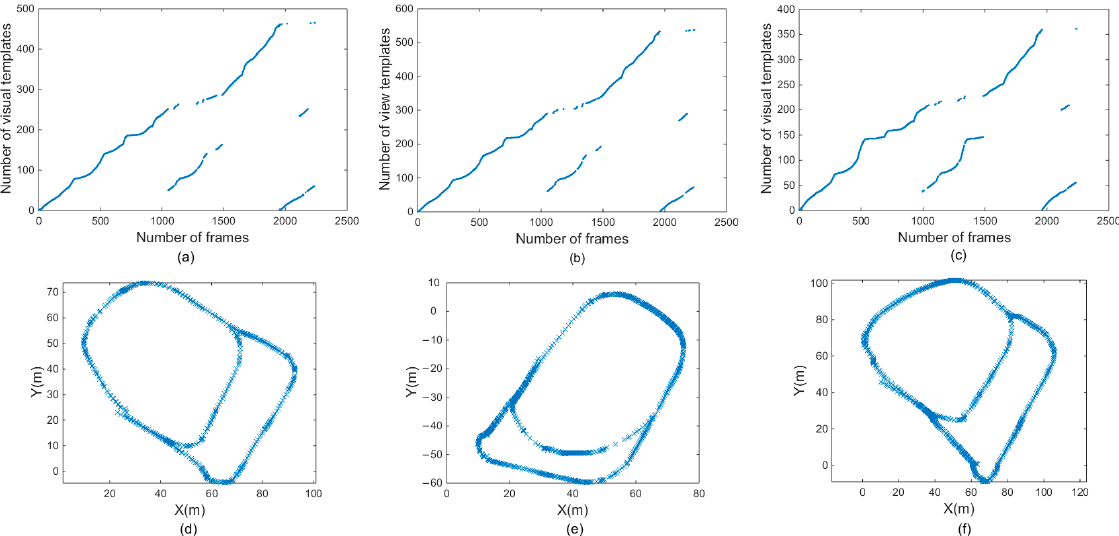
Figure 10. Experimental results of the second scene. ( a , d ) are visual templates and experience map output by traditional RatSLAM. ( b , e ) are visual templates and experience map output by RatSLAM based on FT model. ( c , f ) are visual templates and experience map output by RatSLAM based on HSI model.